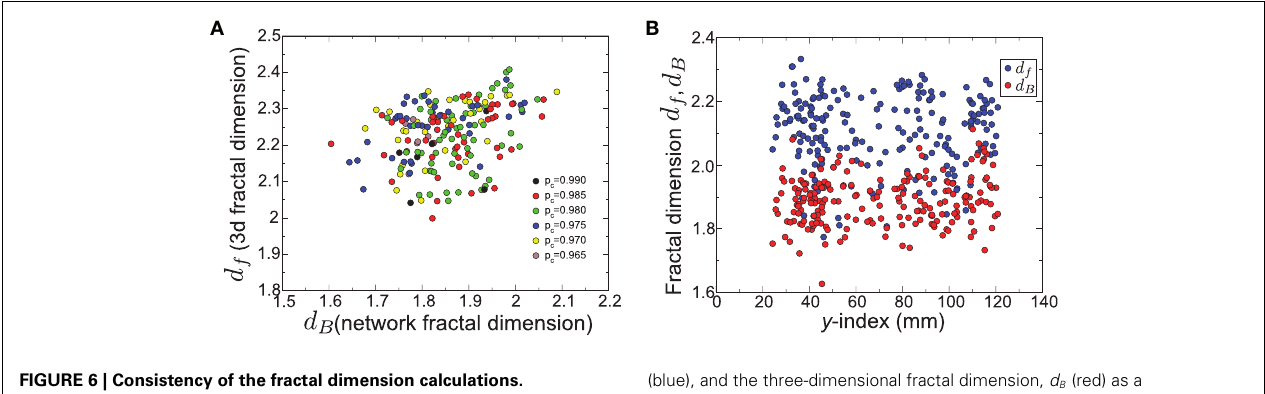
(blue), and the three-dimensional fractal dimension, d B (red) as a function of the location of each cluster.This location corresponds to the center of mass, and is expressed through the y -index, posterior to anterior.